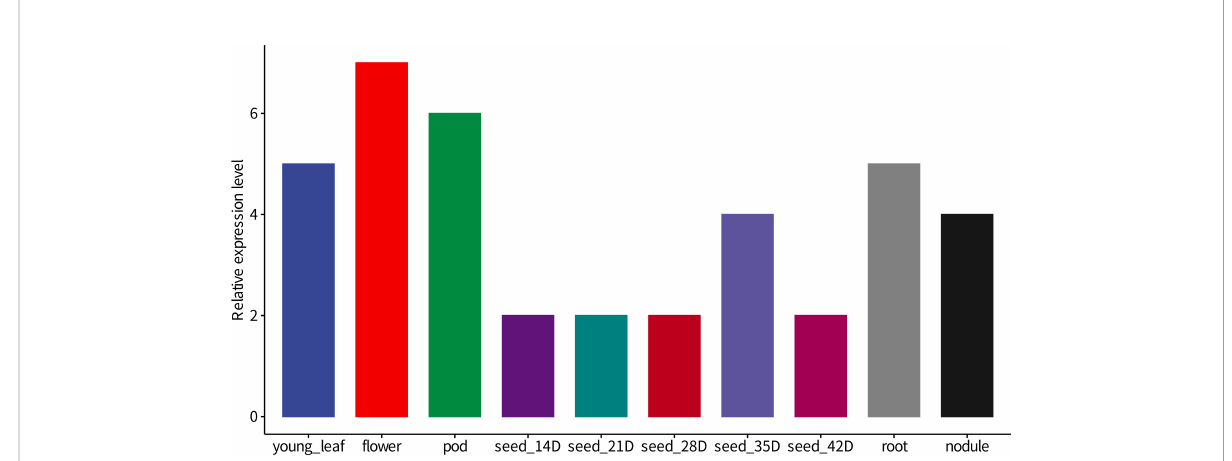
FIGURE 3 The relative transcript level of GmNF-YA8 in different soybean organs Base on public RNA-seq data (www.soybase.org), the relative transcript level Reads Per Kilobase Per Million mapped reads (RPKM) of GmNF-YA8 was shown. POD, one-cm long pod; D, Day after